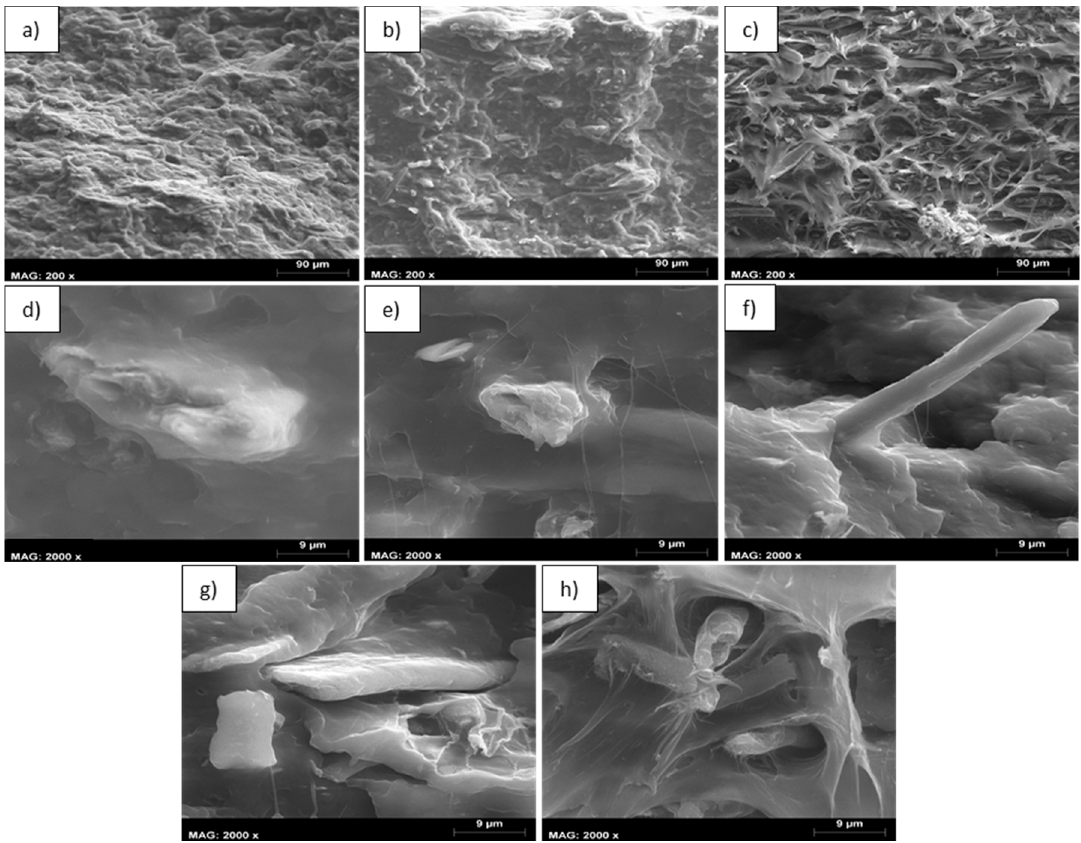
Figure 6. Scanning electron microscopy images of the cross-sectional area of the flexural specimens. ( a ) PP + 20% hemp—5% NaOH (200 × ), ( b ) PP + 20% hemp—7.5% NaOH (200 × ), ( c ) PP + 20%